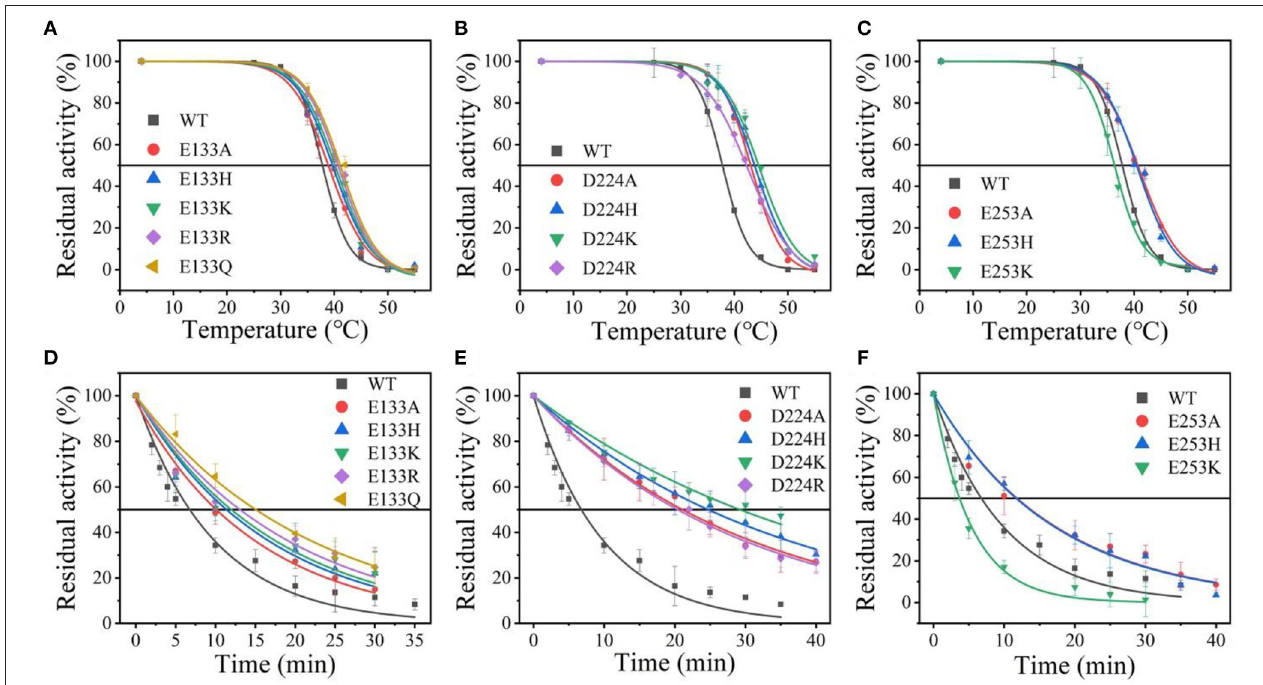
FIGURE 3 | The thermal stability of wild-type At -ATA and its mutants in each site. (A–C) the thermal deactivation of wild-type At -ATA and the 12 variants at various temperatures for 10min ( T 10 50 ), (D–F) the thermal deactivation half-life ( t 1 / 2 ) of wild-type At -ATA and the 12 variants at 40 ◦ C.